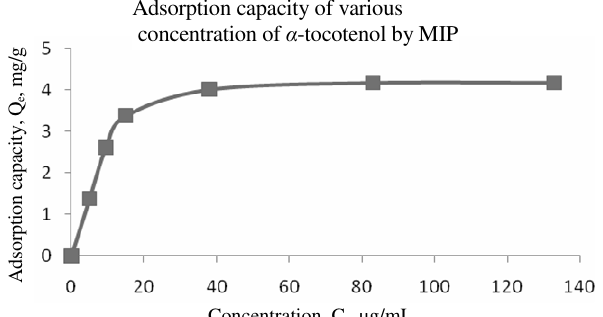
Figure 9. Adsorption isotherms of α -tocotrienol on the cross-linked chitosan-polyacylamide MIP beads. Volume of analyte = 25 mL; Concentration of analyte = 50-300 µg/mL; MIP quantity: 1.0 g; T = 25 o C; adsorption time = 4